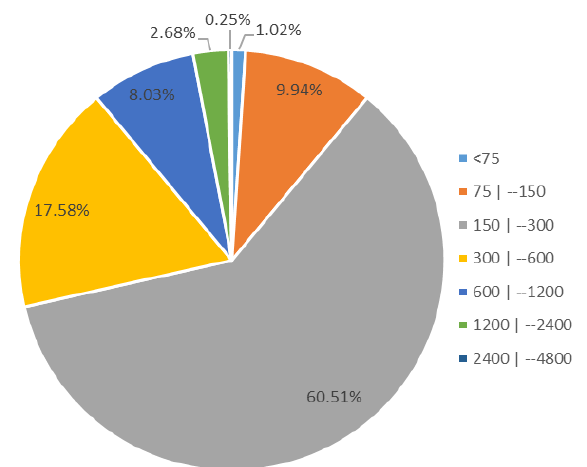
Figure 5. Distribution of the database in relation to the effective depth (in mm).